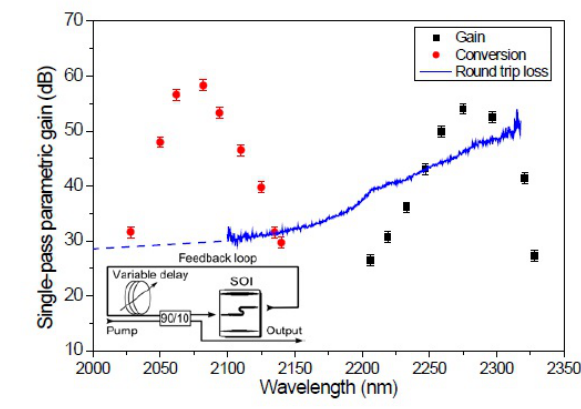
Fig. 24. The parametric gain of the photonic wire waveguide and the round trip-losses of the cavity. The gain can overcome the losses over a broad wavelength band. The inset shows a schematic of the experimental setup. The cross-section of the waveguide is the same as shown in the inset of Figure 12. Adapted from reference [68].